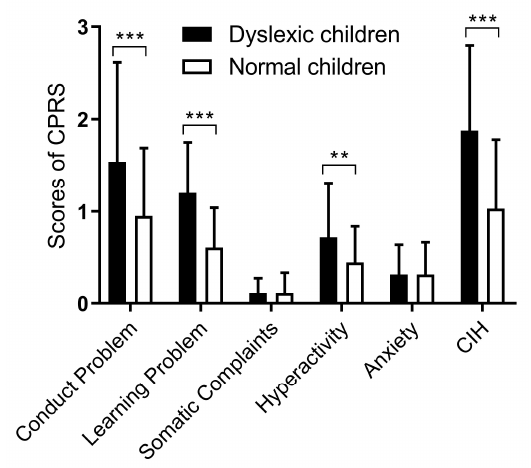
Figure 2. Comparison of Conner’ Parent Rating Scale (CPRS) scores between the dyslexia and control groups. N = 240. ** p < 0.01, *** p < 0.001. CIH, Conners’ Index of Hyperactivity.